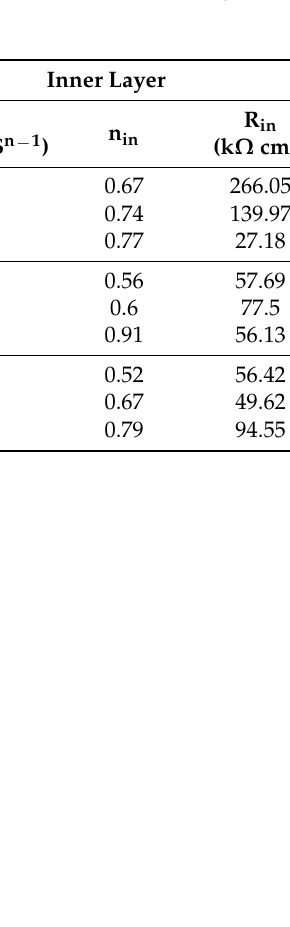
Figure 11. Surface morphology and the elemental maps of the coated specimens after 168 h of im ‐ mersion in 3.5 wt.% NaCl solution for: (a) Mo ‐ 0, (b) Mo ‐ 3, and (c) Mo ‐ 5.